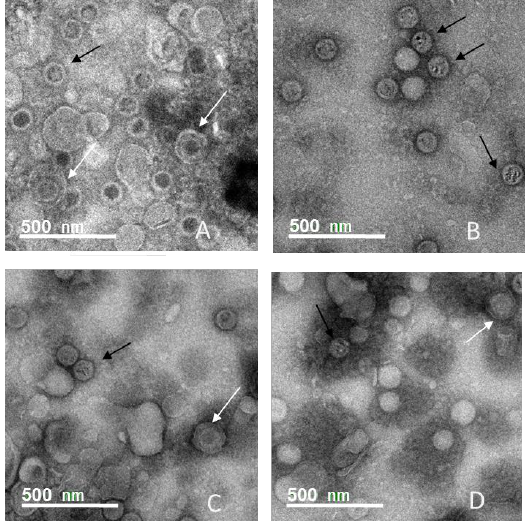
Figure 5. Electron micrograph images of HSV-1 virions treated with different surfactants. The images were HSV-1 virions without treatment ( A ), virions treated with 0.009% of 222B ( B ), 0.009% of SDS ( C ), and 0.009% of Triton X-100 ( D ), respectively. The black arrow indicates the capsids of virions without envelopes. The white arrow indicates the envelope of the virion. Scale bar = 0.5 µ m.